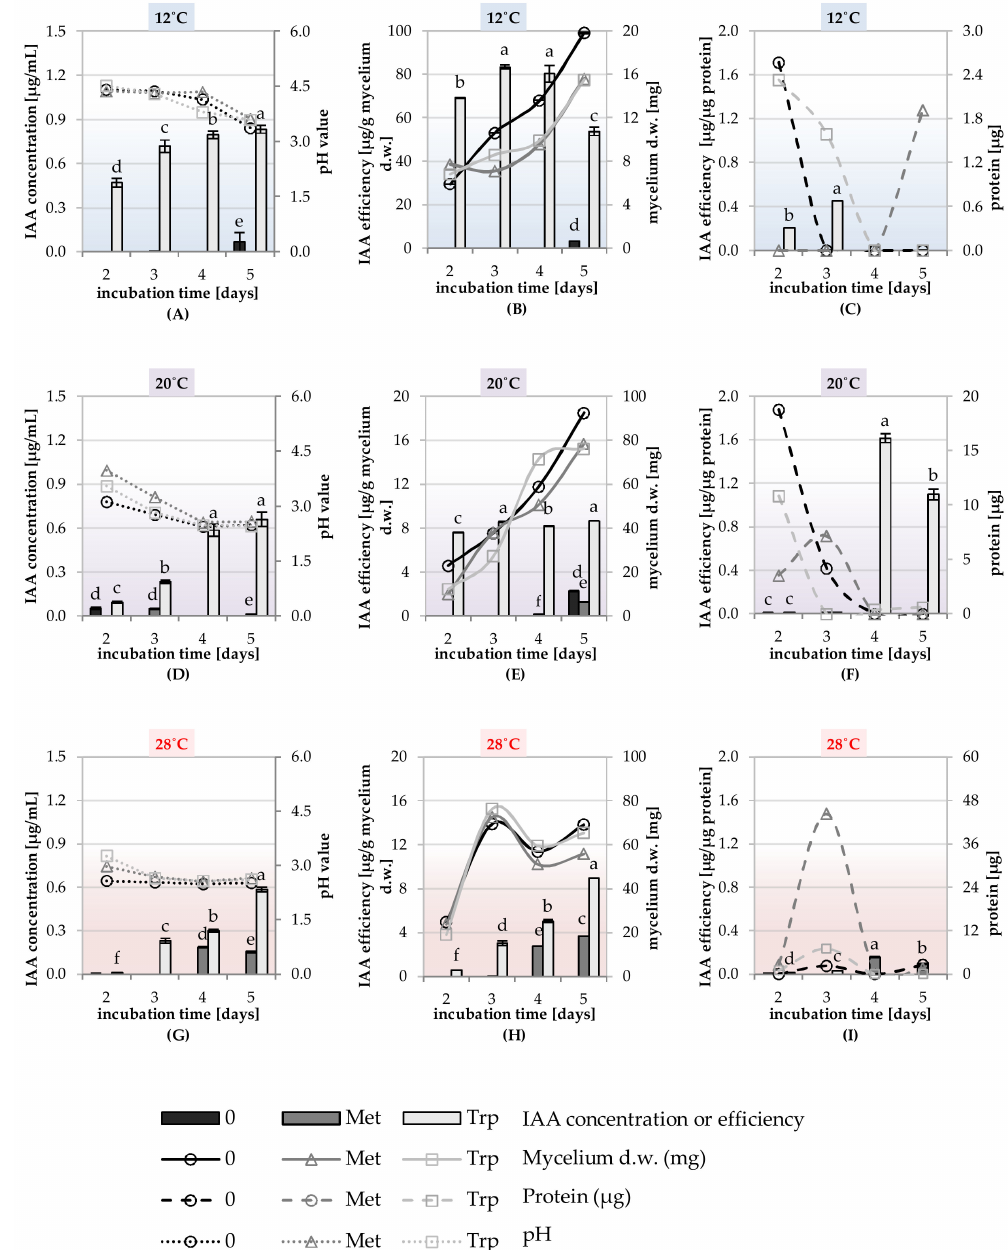
Figure 8. The indoleacetic acid (IAA) concentration and e ffi ciency of IAA synthesis in Trichoderma DEMTkZ3A0 strain cultures grown in RB modified medium supplemented with 3.0 mM Met and Trp or without amino acids after 2, 3, 4, and 5 days incubation at 12 ◦ C ( A , B , C ), 20 ◦ C ( D , E , F ) and 28 ◦ C ( G , H , I ). Bars represented standard deviations (SD). Values followed by di ff erent letters are significantly di ff erent (one-way analysis of variance (ANOVA) followed by a Tukey’s post hoc test with the significance evaluated at p <